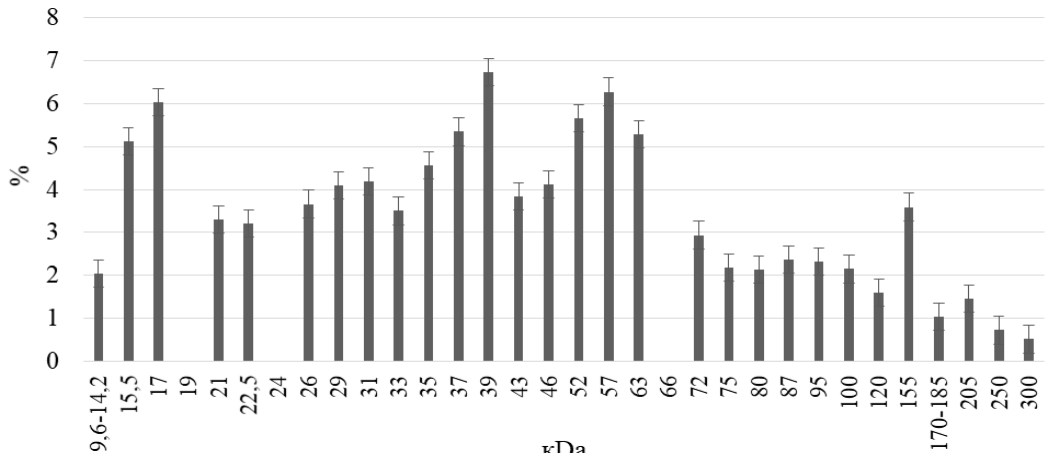
Fig. 1. Structural proteins of the apical membrane of the jejunum enterocytes of five-months-old cattle fetus (M ± m; %; n = 6) It should be noted that protein fractions with low molec- ular weight (up to 24 kDa) were only 19.7 %, in particular, proteins with a molecular weight of 9.6–14.2 kDa